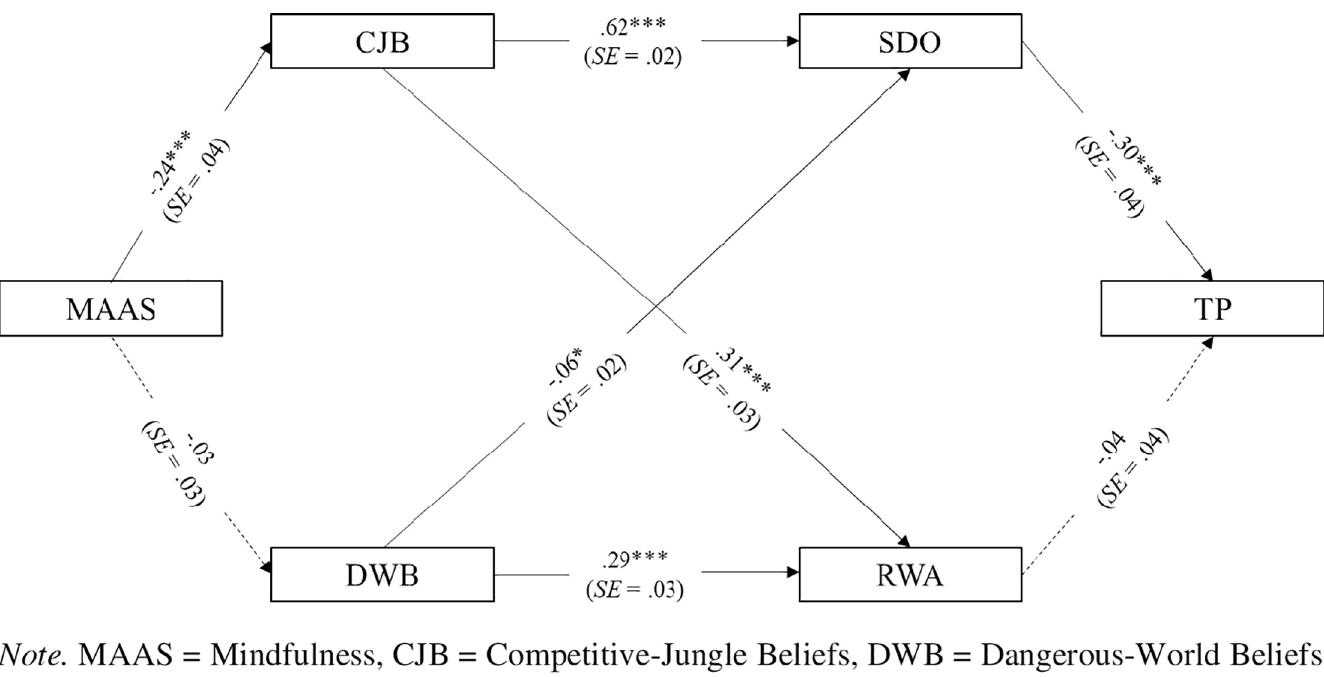
Fig 2. Path analysis model with sequential mediators in Study 2 ( N = 722): Standardized parameters.